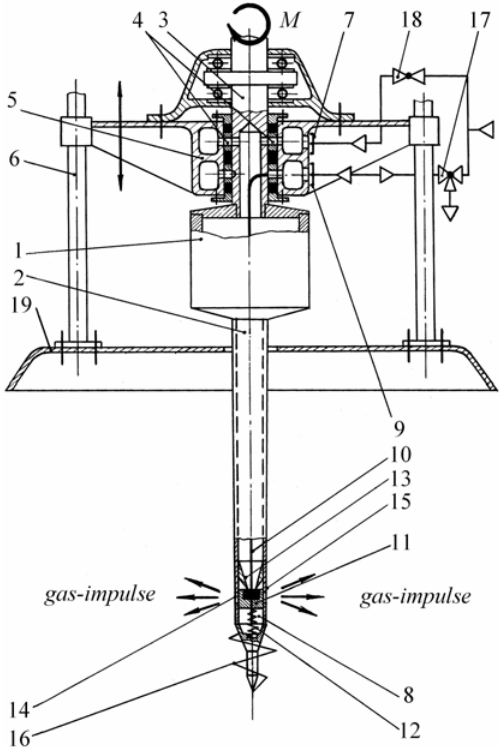
Fig. 2. A schematic view of gasodynamic soil loosening